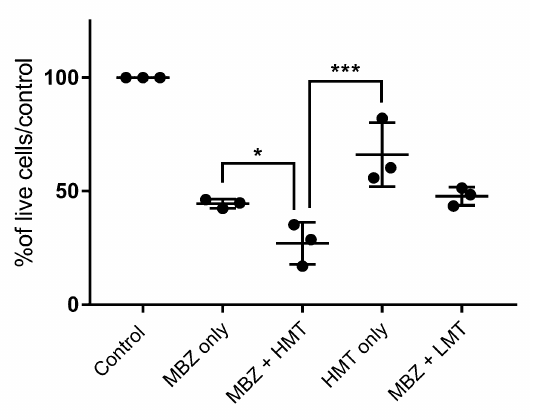
Figure 2. In vitro impact of MBZ alone and in combination with Viscum album on canine SDT-3G glioma cells. Cells were incubated for 72 h with either MBZ (0.03 μM) only, mistletoe (5 μg/mL) only, or combined 0 .03 μM MBZ + high mistletoe (“HMT”, 5 μg/mL) or MBZ + low mistletoe (“LMT”, 2.5 ng/mL) before cell viability was evaluated with MTT assays. Data are shown as a percentage of viable cells in the treatment group as compared to untreated control cells, with each dot representing the mean of technical replicates for a given experiment. * is statistically significant ( p ≤ 0.05); *** is highly significant ( p < 0.001).